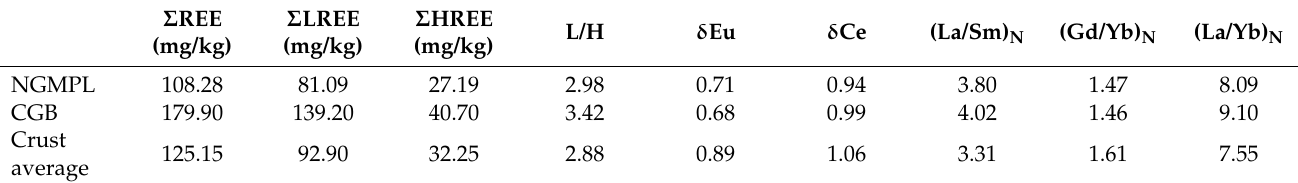
Table 6. Rare earth element characteristic parameter